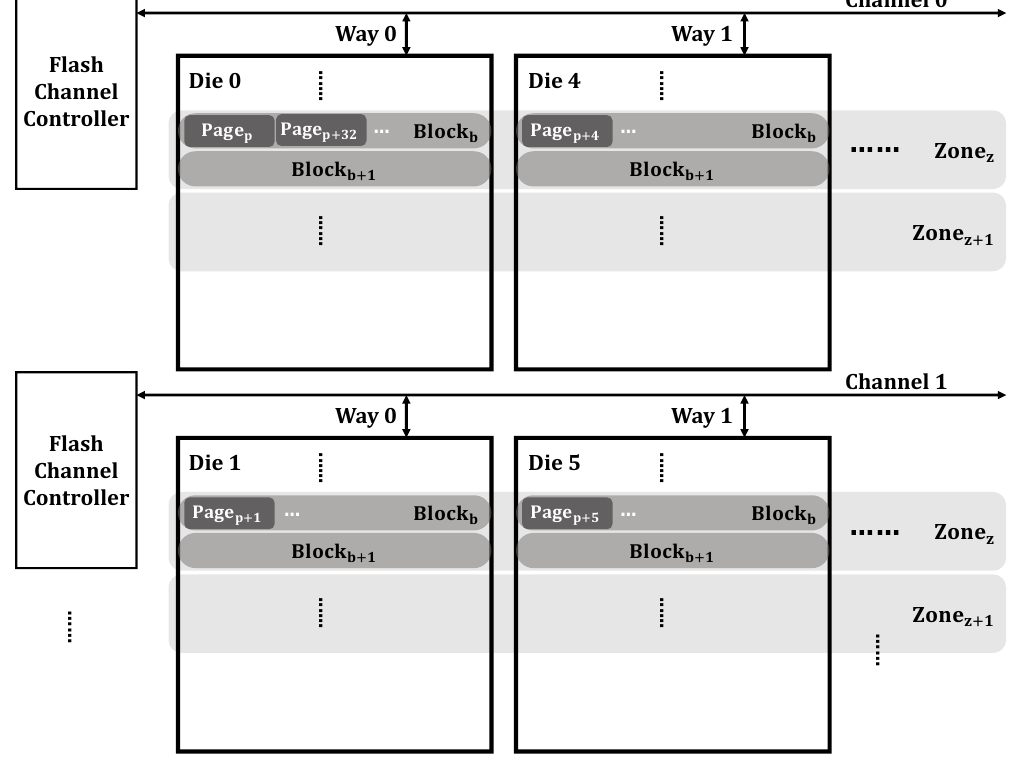
Figure 3. Physical layout of ZNS prototype. Zone size is configured as two erase blocks. As previously stated, contiguous pages are striped across dies, and every 256 pages on the 32 dies are grouped together to form an erase block. For our physical layout, we chose